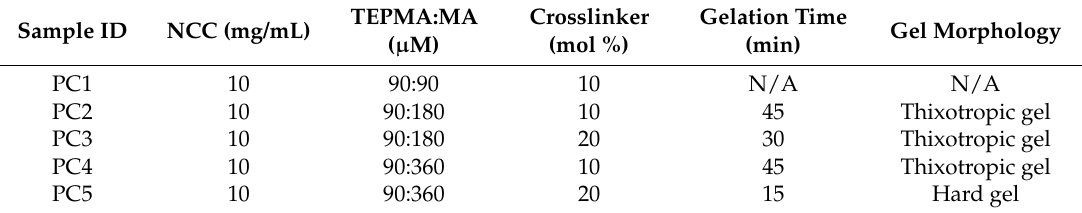
Table 1. The stoichiometric ratios of monomers and crosslinker studied for the synthesis of polymeric